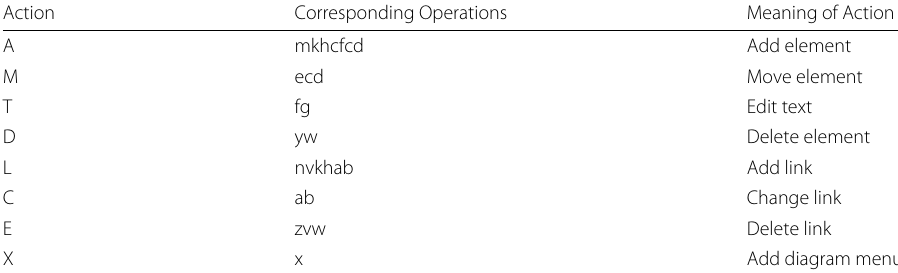
Table 3 Re-symbolization of grouping operations as actions Action Corresponding Operations Meaning of